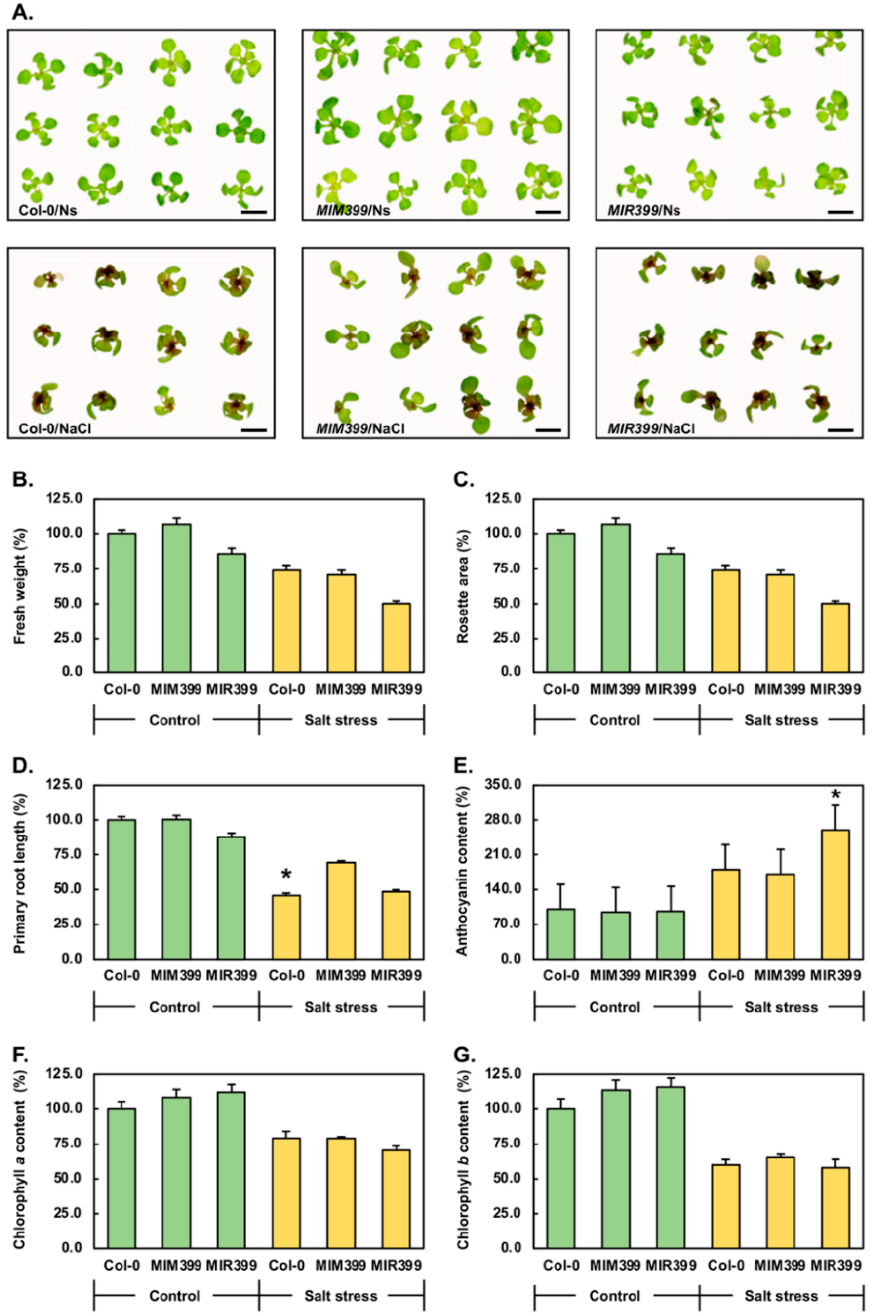
Figure 2. Phenotypic and physiological responses of Col-0, MIM399 and MIR399 plants to salt stress. ( A ) Phenotypes displayed by 15-day-old Col-0/Ns, MIM399 /Ns, MIR399 /Ns, Col-0/NaCl, MIM399 /NaCl and MIR399 /NaCl seedlings. Quantified phenotypic parameters of fresh weight ( B ), rosette area ( C ) and primary root length ( D ) for 15-day-old Col-0/Ns, MIM399 /Ns, MIR399 /Ns, Col-0/NaCl, MIM399 /NaCl and MIR399 /NaCl seedlings. Quantification of the physiological parameters of anthocyanin ( E ), chlorophyll a ( F ) and chlorophyll b ( G ) content in 15-day-old Col-0/Ns, MIM399 /Ns, MIR399 /Ns, Col-0/NaCl, MIM399 /NaCl and MIR399 /NaCl seedlings. Error bars represent the standard deviation of four biological replicates and the presence of an asterisk above a column represents a statistically significant difference in either a phenotypic or physiological pa- rameter between the Col-0 plants and the MIM399 and MIR399 transformant lines ( p -value: * <